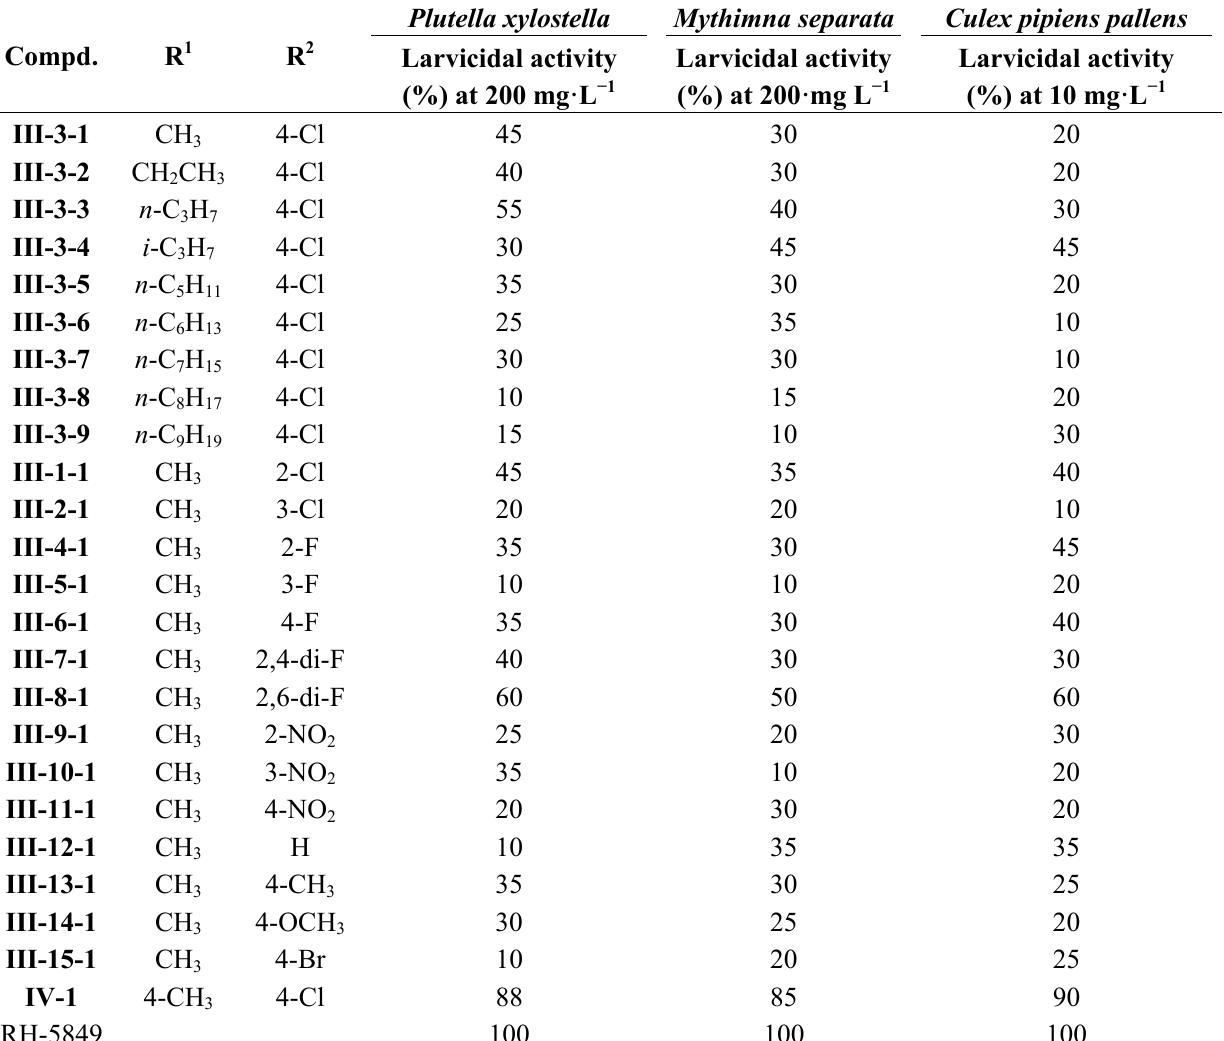
Table 4. Larvicidal activity of title compounds III